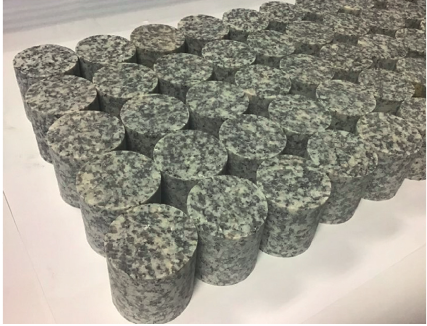
Figure 2: Processed specimens of